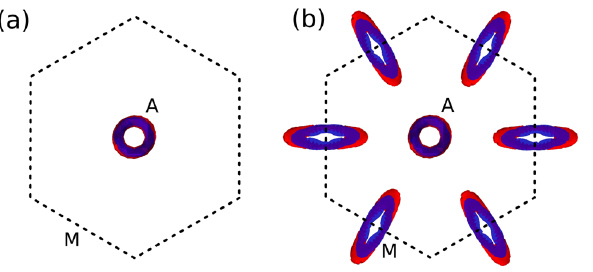
Figure 5. Top view of the TB band touchings within the first Brillouin zone at the Fermi level. The valence (conduction) band is shown in red (blue): ( a ) for P = 0 GPa (T1), the snake-like nodal line is formed around the A point, ( b ) for P = 6 GPa (T2), new nodal lines appear around the M points.